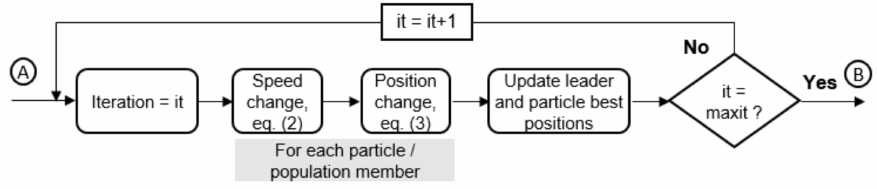
Figure 4. The flowchart of a PSO iteration.